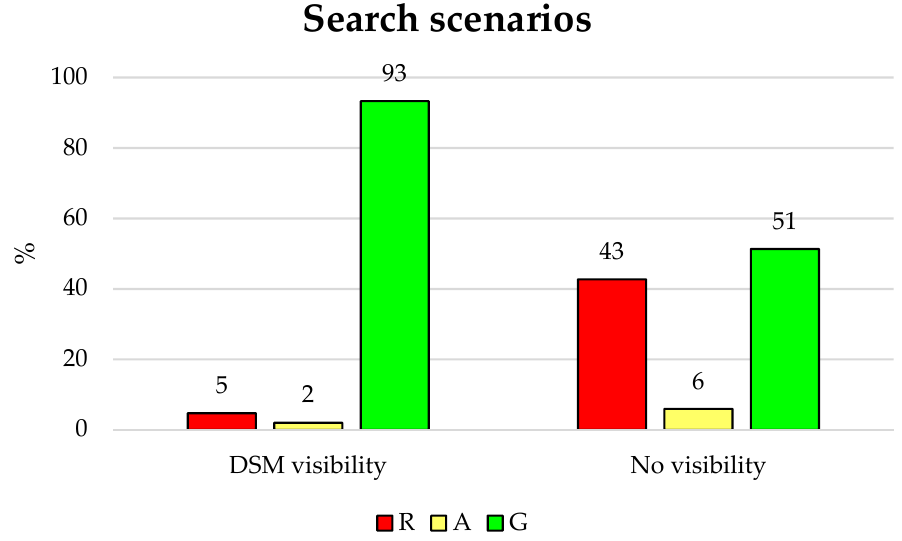
Figure 20. Histograms showing the percentages for each search scenario. Legend: R: Red code, A: Amber code, G: Green code. DSM visibility: DSM Search scenario, No visibility: Search scenario without visibility.